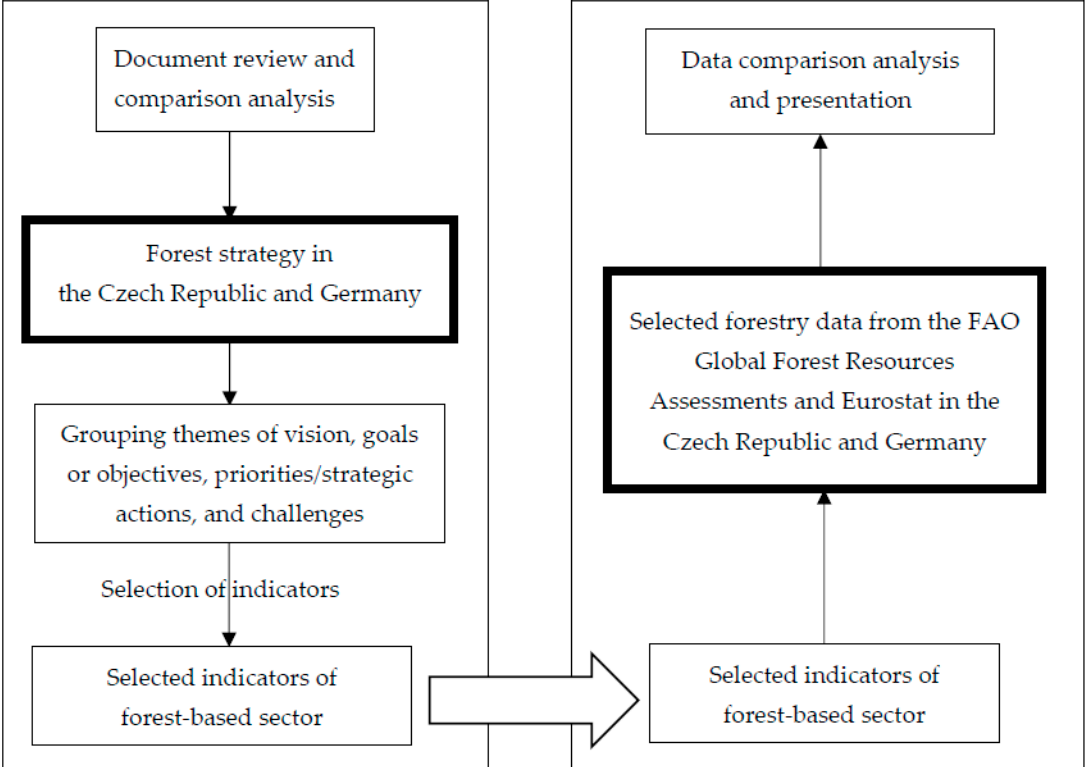
Figure 1. Study framework of the document review and data comparison analysis in Germany and the Czech Republic.